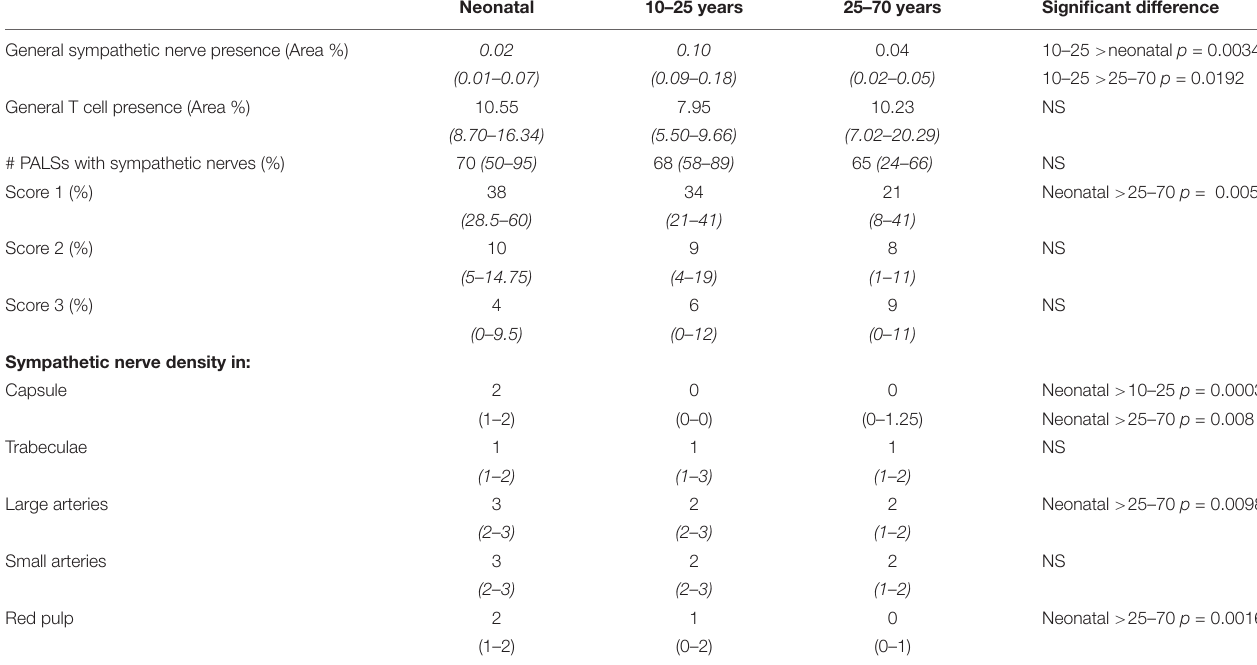
TABLE 4 | Age related variations of T cell and sympathetic nerve